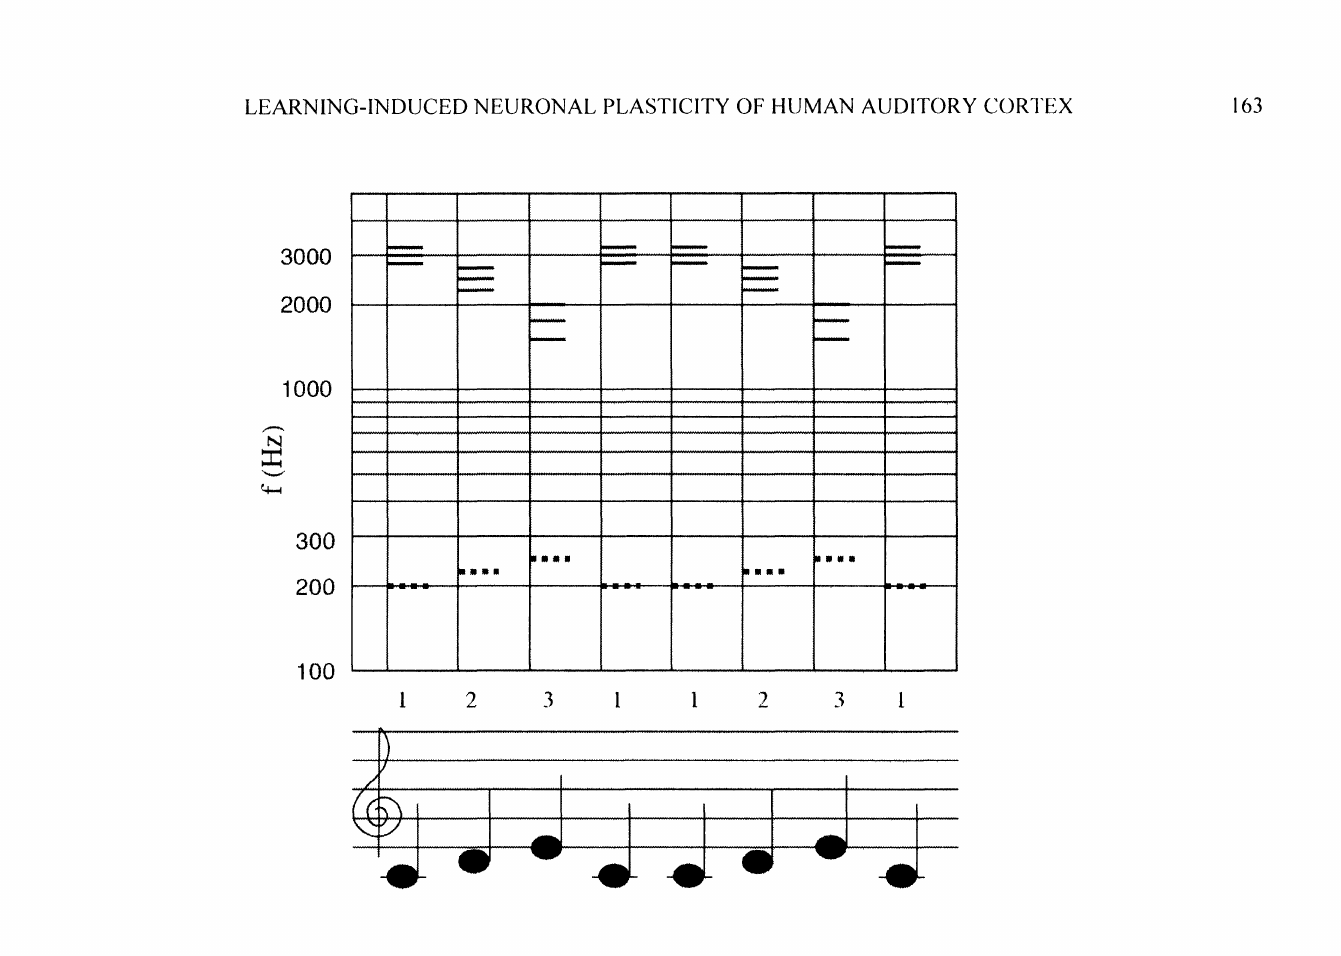
Fig. 1: Stimulus sequence of the virtual pitch melody. The sequence is built up of three different complex tones (f0, tonel: 200 Hz, f0, tone2:225 Hz and f0, tone3:250 Hz), played in the order 12311231. The virtual melody follows the tune ’Fr6re Jacques’ (lower inset: notation transposed to C major, upper inset: dotted lines), whereas the spectral melody, given by three upper harmonics, has an inverse pitch contour (upper inset: solid lines).